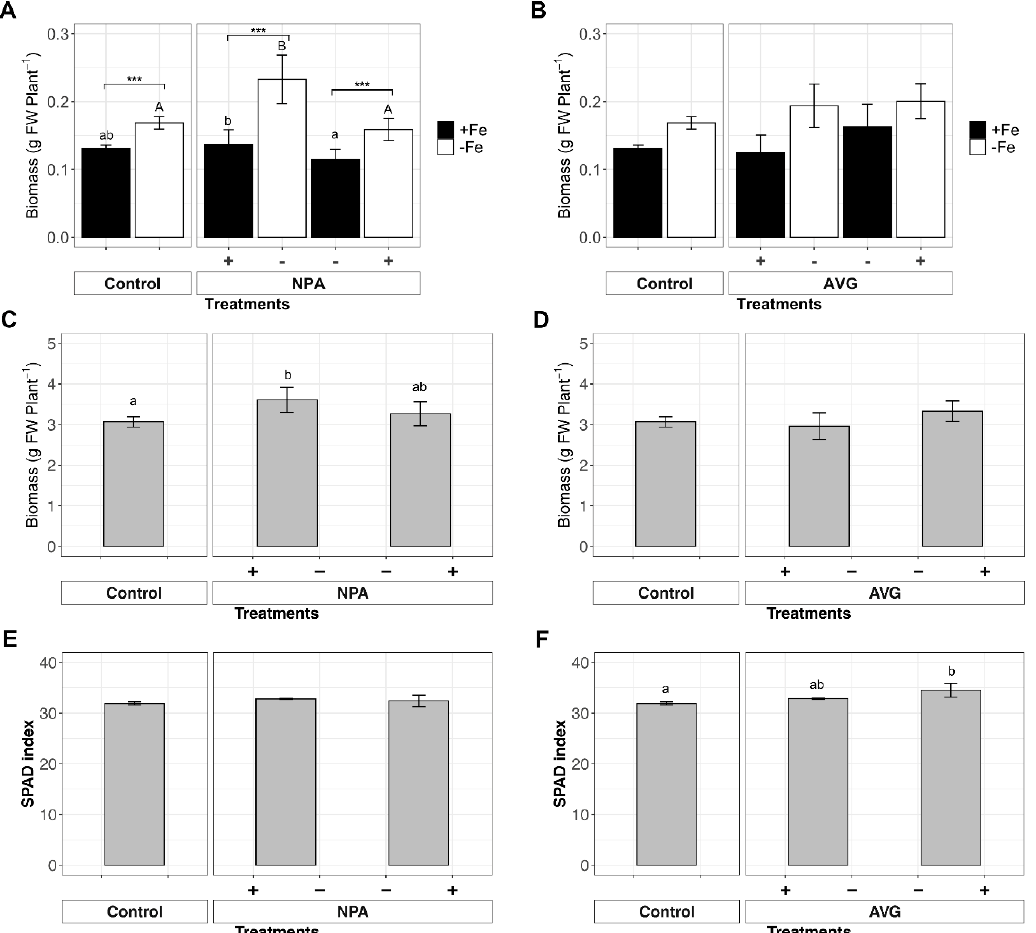
Figure 2. Growth parameters of split-root tomato plants: ( A ) root biomass of split-root tomato plants not-supplemented (control) or supplemented with polar auxin transport inhibitor naphthylphthalamic acid (NPA); ( B ) root biomass of split-root tomato plants not-supplemented (control) or supplemented with ethylene signaling inhibitor aminoethoxyvinylglycine (AVG); ( C ) shoot biomass of